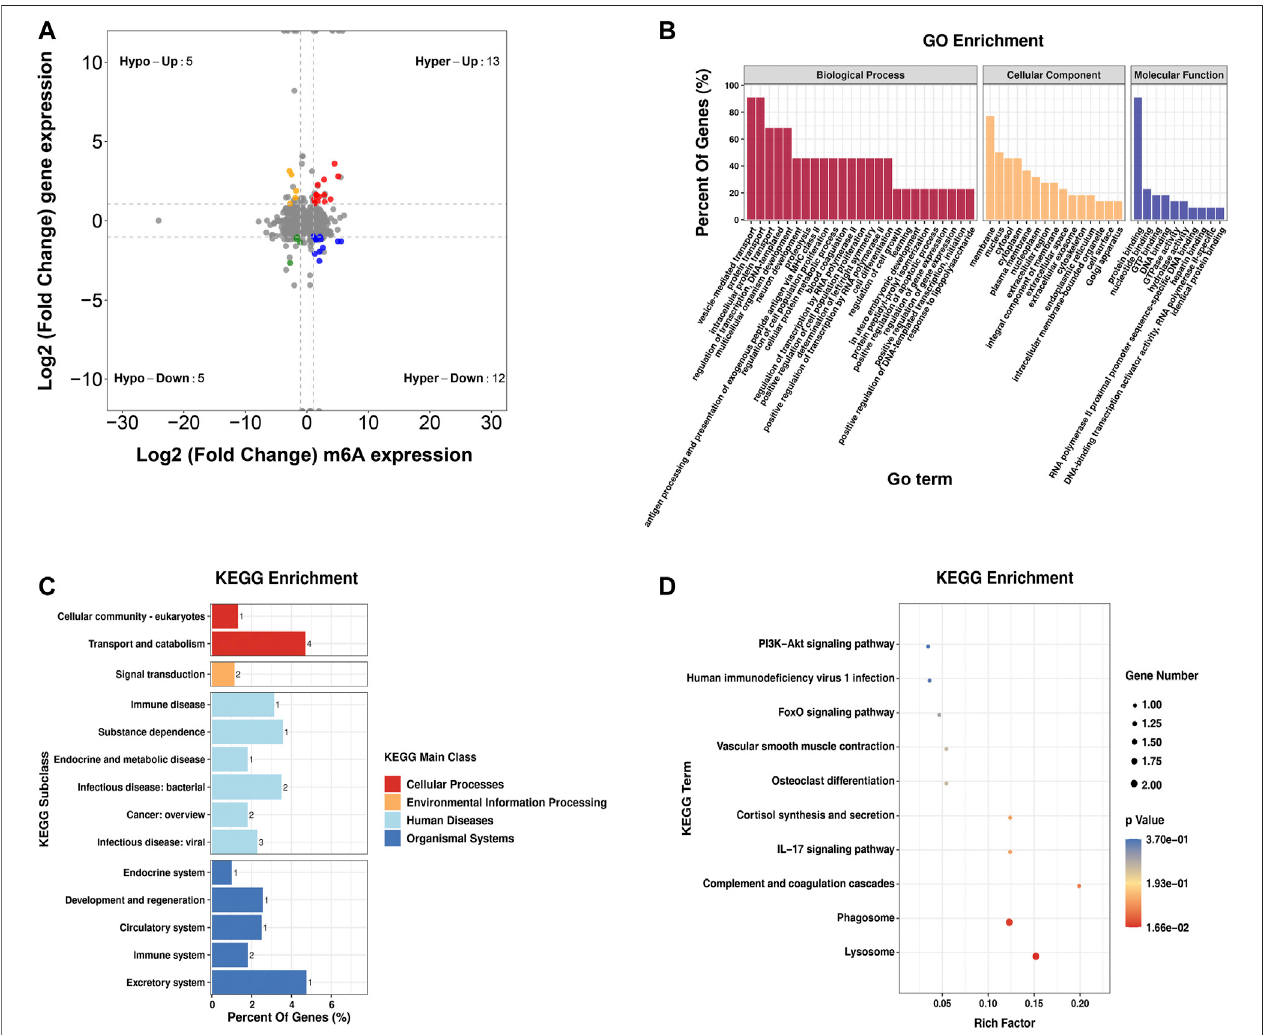
FIGURE5| ConjointanalysisoftheMeRIP-seq and RNA-seq data. (A) Distributionofgeneswithagreatvariationinboth them 6 Amodi fi cation and mRNAlevels in the PBMCs ofRA relative tothatofCon. (B) GO enrichment explorationofgeneswithgreatvariationin both them 6 Amodi fi cation and mRNAlevels. (C) KEGG subclass of genes with great variation in both the m 6 A modi fi cation and mRNA levels. (D) KEGG pathway enrichments of differentially expressed genes at both the m 6 A modi fi cation and mRNA levels. PBMCs, peripheral blood mononuclear cells; RA, rheumatoid arthritis; Con, control group; GO, Gene Ontology; m 6 A, N 6 - methyladenosine; and KEGG, Kyoto Encyclopedia of Genes and